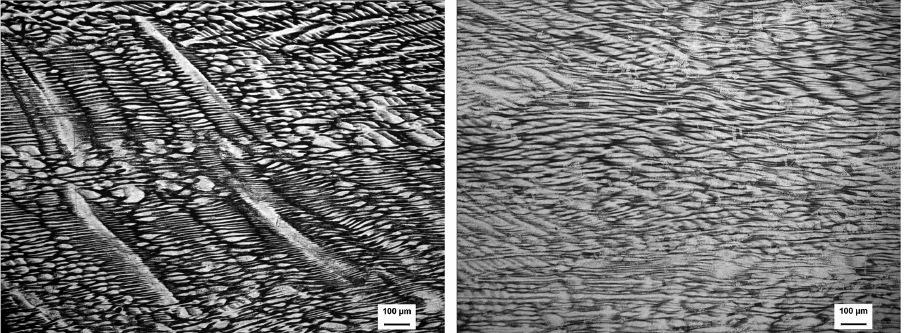
Figure 8: Metallographic structure of BFe10-1-2 alloy under the deformation condition of (a) 1,023K 0.01s − 1 , (b) 1,223K 0.1s − 1